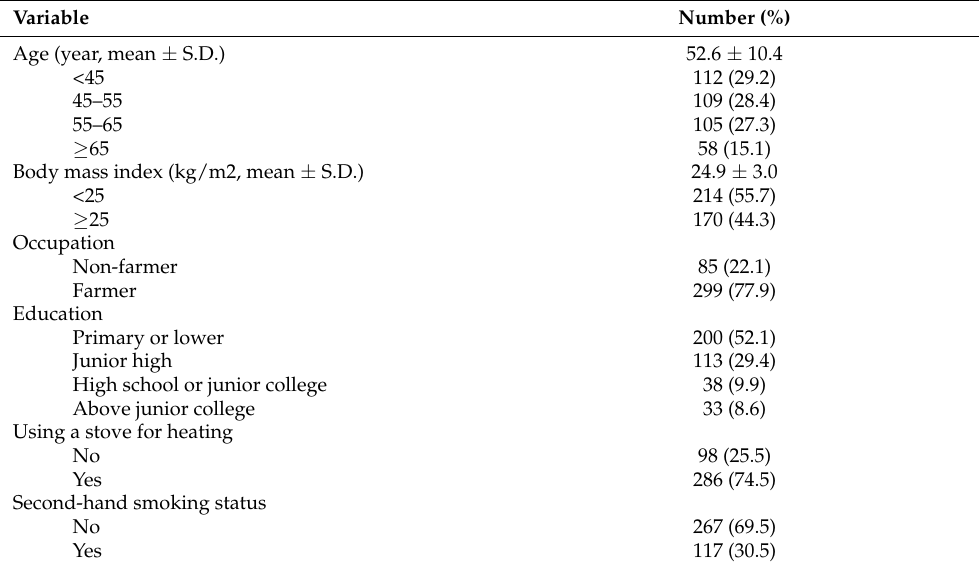
Table 1. Basic characteristics of participants in Pingding county, Shanxi Province, Northern China,